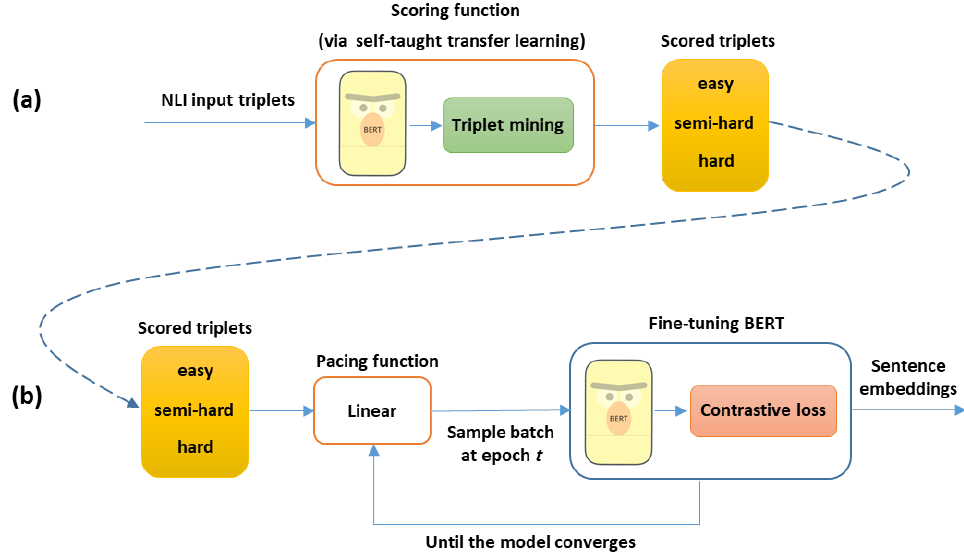
Figure 3. SelfCCL model; ( a ) Easy-to-hard triplets mining using BERT in a self-taught way; ( b ) Cur- riculum contrastive based fine-tuning of